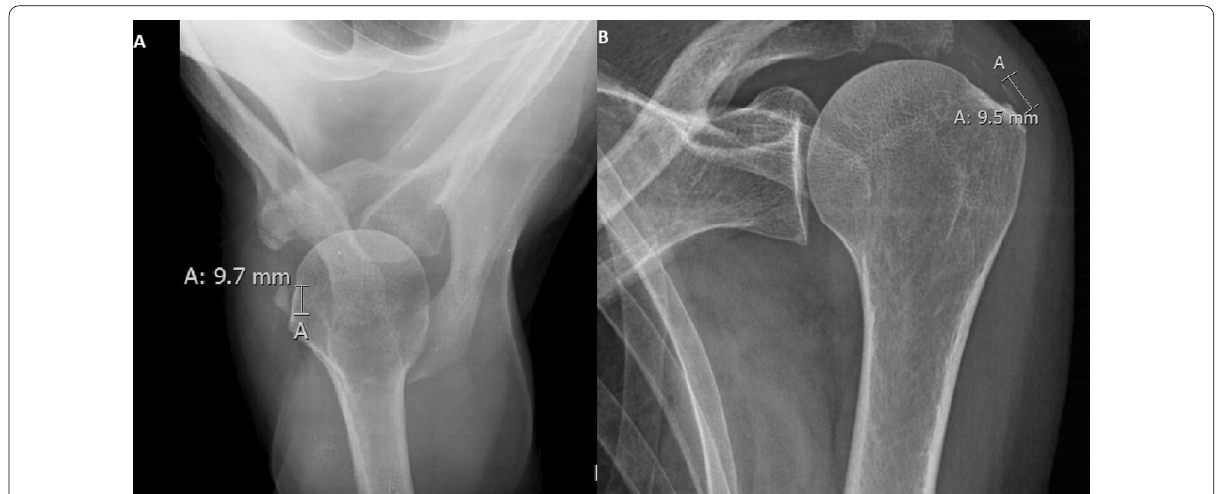
Fig. 5 Anteroposterior shoulder x-ray performed at baseline ( A ) and after 10 years ( B ) shows the same length of calcification at follow-up